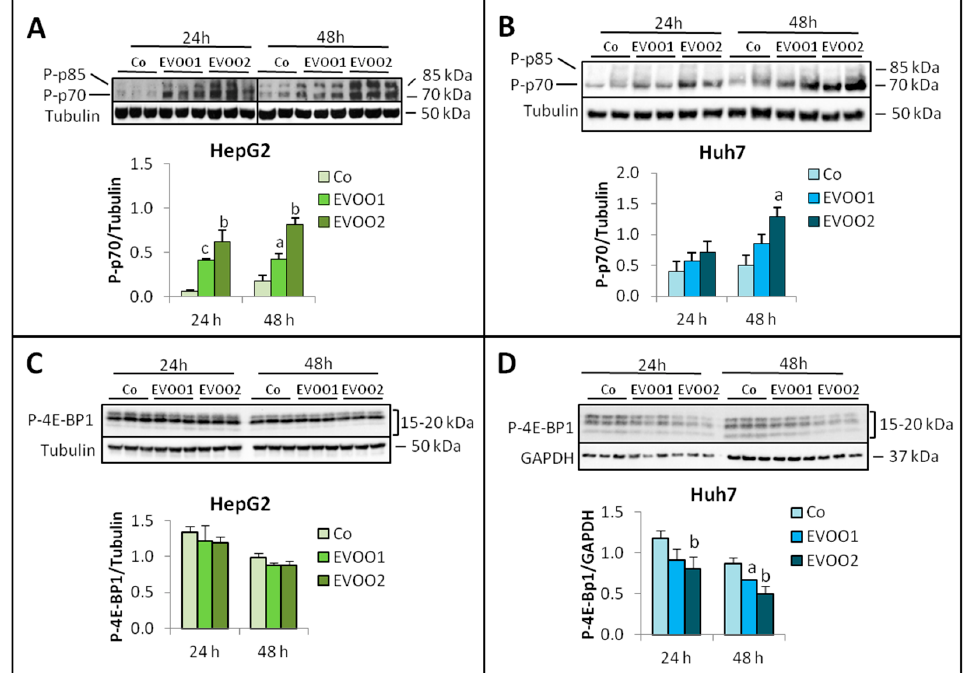
Figure 6. EVOO modulates the expression of P-p70 and P-4E-BP1. The cell lines were incubated for 24 and 48 h with two different doses of the phenolic extract. ( A , C ) Expression of P-p70 and P-4E-BP1 in HepG2 cell line. ( B , D ) Expression of P-p70 and P-4E-BP1 in Huh7 cell line. The results are representative of three experiments. The protein molecular weights are reported. Data are presented as mean ± SD. (a: p < 0.05, b: p < 0.01 versus Control).